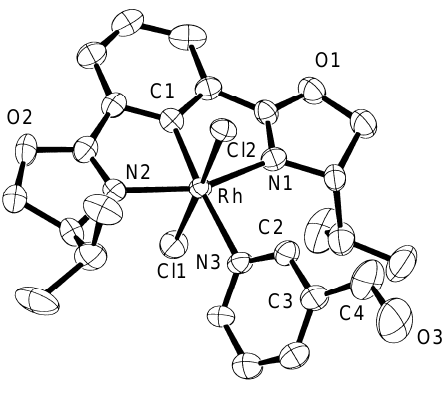
Figure 2. Molecular structure of ( i -Pr-Phebox)RhCl molecules and one H O in the unit cell. 2